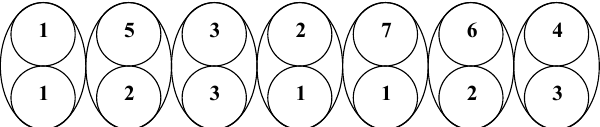
Figure 2. A sample chromosome for solving the charge scheduling problem with multiple chargers.